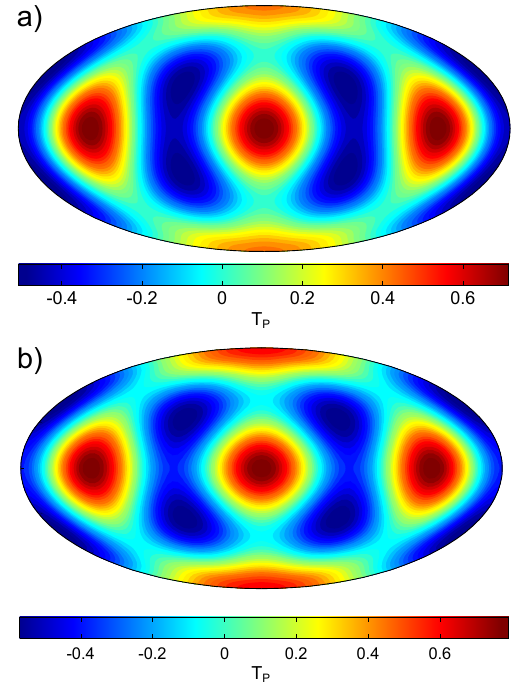
Figure 11. θ − λ temperature dependence of the five cells’ initial condition (Eq. 11) with (a) γ = 1 and (b) γ = 11 2 10